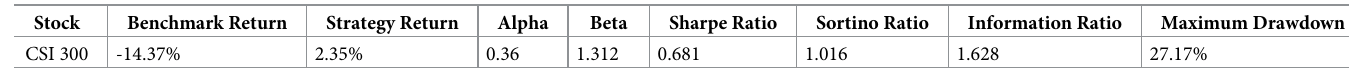
Table 6. Summary of CSI 300 constituent stock strategy returns.